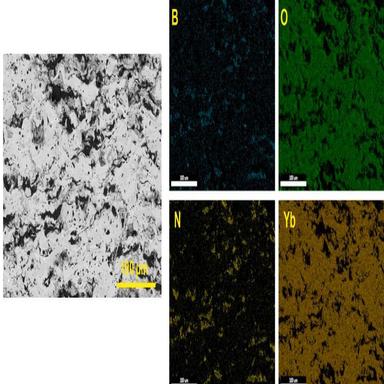
Cross-sectional morphology and element distribution of Y–10BN coating.